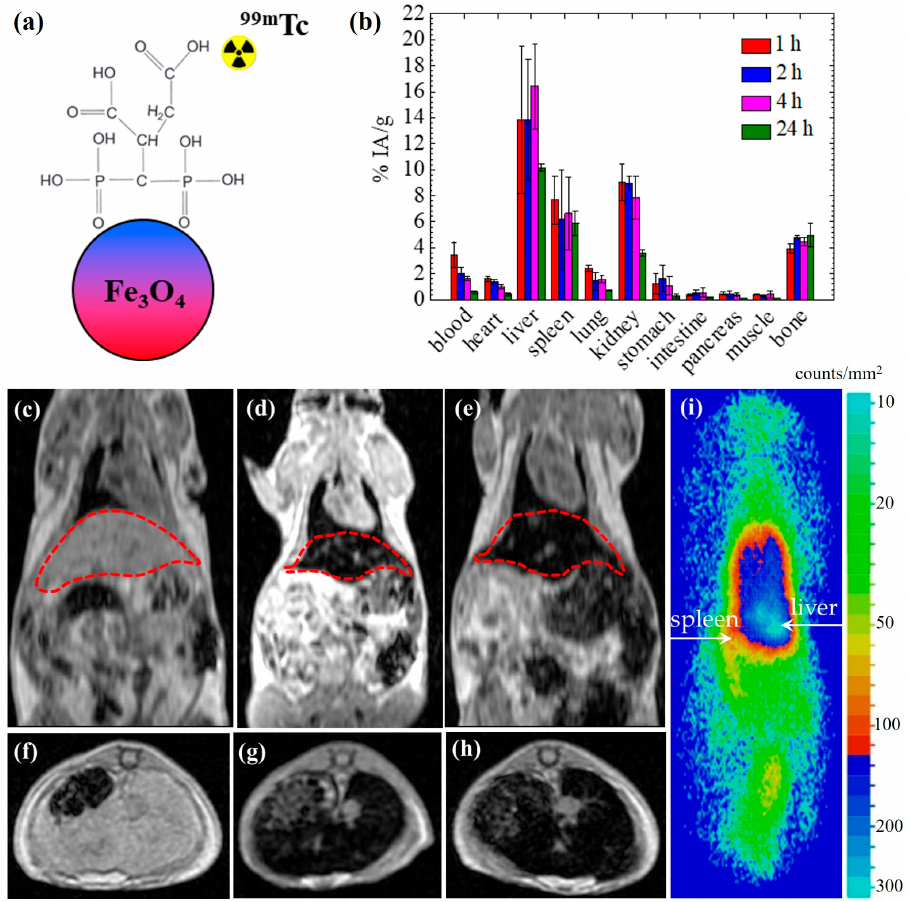
Figure 4. ( a ) The structure of 99m Tc radiolabeled and 2,3-dicarboxypropane-1,1-diphosphonic acid coated IONs; ( b ) The biodistribution of RIONs in normal mice at 1, 2, 4, and 24 h p.i.; representative T 1 -weighted ( c – e ) coronal and ( f – h ) axial MRI data of n = 4 normal Swiss mice; ( c , f ) without any RIONs/non-radiolabeled IONs; ( d , g ) with non-radiolabeled IONs at a concentration of C = 0.1 mg/mL; ( e , h ) with RIONs at C = 0.1 mg/mL; the MR imaging was performed at 6 h p.i. The areas of interest, that is, the liver and spleen, are demonstrated by the dotted red lines; ( i ) Representative coronal image of a mouse injected with RIONs obtained at 4 h p.i. by gamma camera [40].